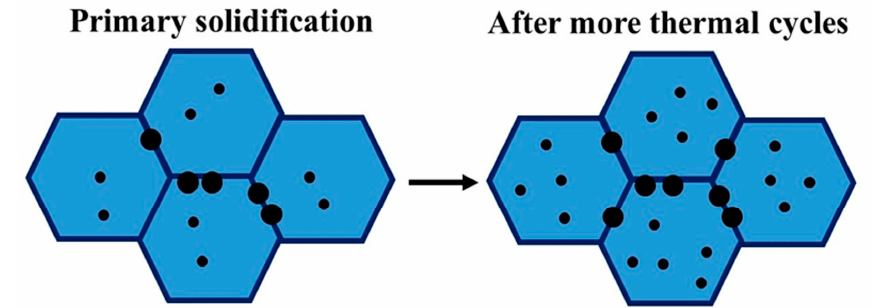
Figure 6. Schematic diagram of cellular dendritic structures of as-built HX samples. The black circle represents the Mo-rich carbides whereas the blue and dark blue areas represent the dendritic and interdendritic regions, respectively.